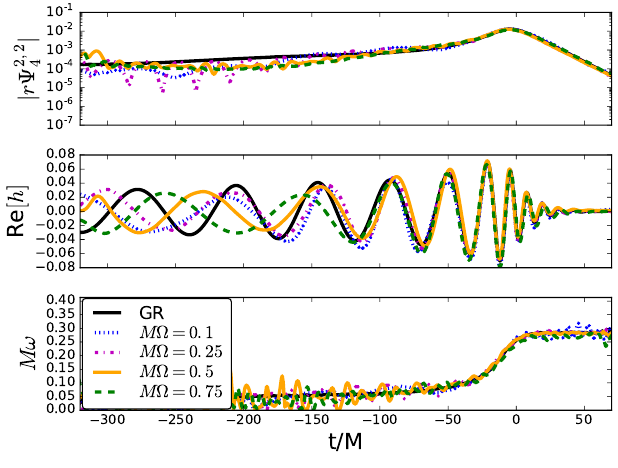
Figure 3 . Results of varying the (cid:13)uctuation frequency (cid:10) for the inspiral and coalescence of two, equal-mass black holes. These runs have A = 0 : 5 M and R 0 = 0 : 3 M . The same quantities as shown in (cid:12)gure 2 are presented here, and again the times and overall phases of the nonviolent nonlocality waveforms have been shifted to maximize the overlap with the GR